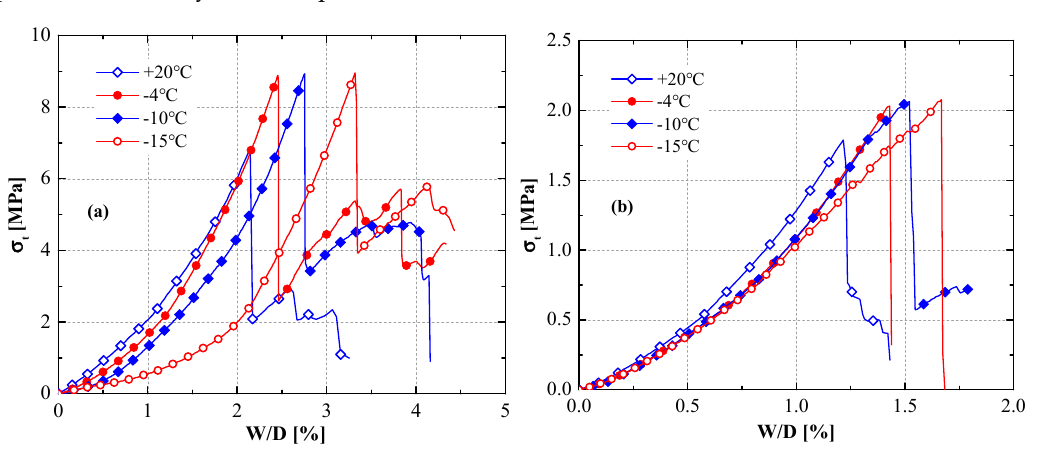
Table 1. Sample physical parameters.